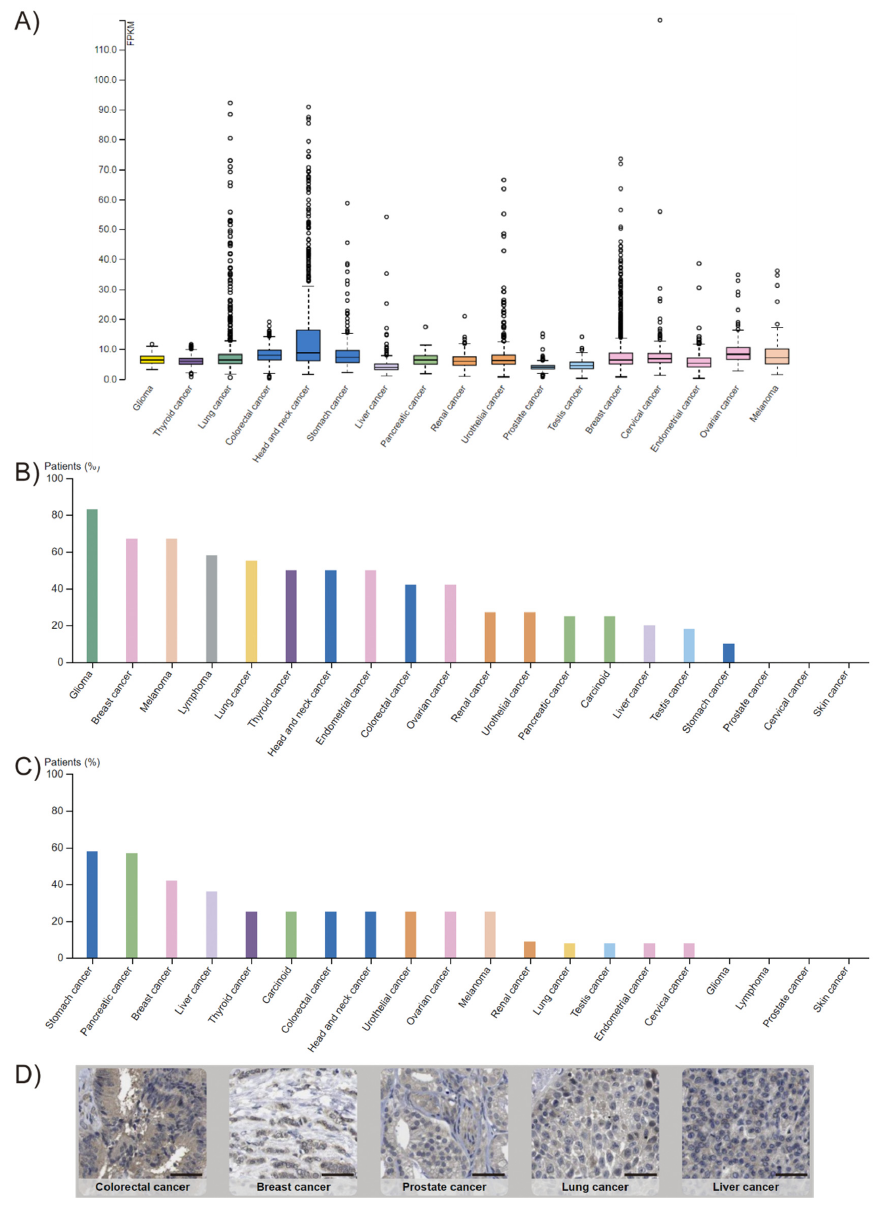
Figure 2. FADD expression in cancer. ( A ) RNA-sequencing data from The Cancer Genome Atlas (TCGA) project of Genomic Data Commons (GDC). Seventeen cancer types representing 21 cancer subtypes with a corresponding major cancer type in The Human Pathology Atlas were included to allow for comparisons with the protein staining data from The Human Protein Atlas. The FPKMs (number fragments per kilobase of exon per million reads) were used for quantification of expression with a detection threshold of 1 FPKM. ( B , C ) FADD protein levels from The Human Protein Atlas. For each cancer, color-coded bars indicate the percentage of patients (maximum: 12) with high and medium protein expression level. Low or not detected protein expression results in a white bar. ( B ) Results obtained using HPA001464 antibody. Cases of colorectal, breast, ovarian, urothelial, gastric, pancreatic, and liver cancers, and melanomas showed weak to moderate cytoplasmic positivity. The remaining cancers were negative. ( C ) Results obtained using CAB010209 antibody. The majority of cancer cells showed weak to moderate cytoplasmic positivity. Nucleolar staining was observed in several cases. A few breast cancers were strongly stained. ( D ) Selection of five standard cancer tissue samples representative of the overall staining pattern. Scale bar: 50 µ